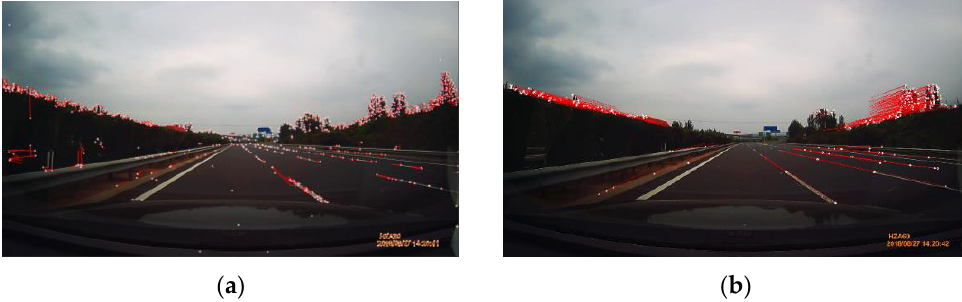
Figure 2. Examples of motion vectors detected from ( a ) two consecutive frames by the existing method and ( b ) several consecutive frames by the proposed stable motion detection method.